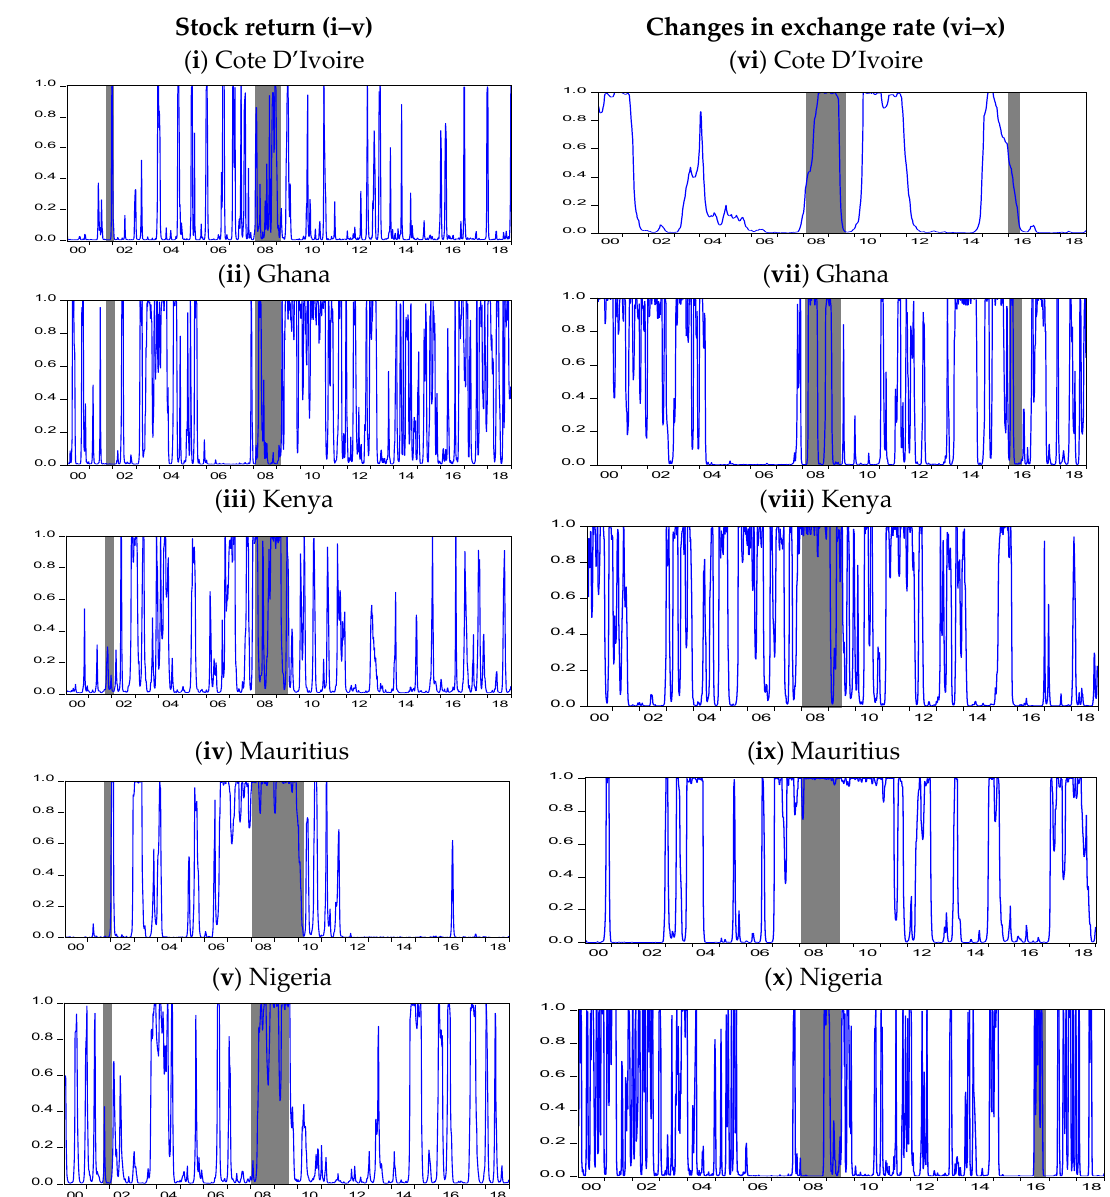
Figure 2. ( i – v ) show the probability of the stock returns being in regime 2. ( vi – x ) show the probability of exchange-rate changes being in regime 2.